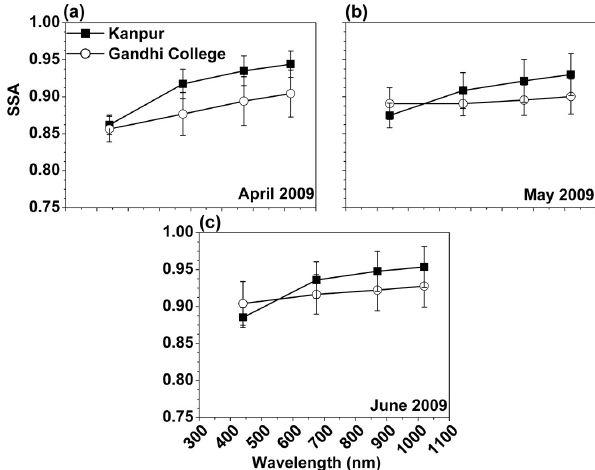
Fig. 6. Spectral variations of SSA at four discrete wavelengths (440, 675, 880 and 1020nm) at Kanpur and Gandhi College dur- ing (a) April 2009, (b) May 2009 and (c) June 2009.